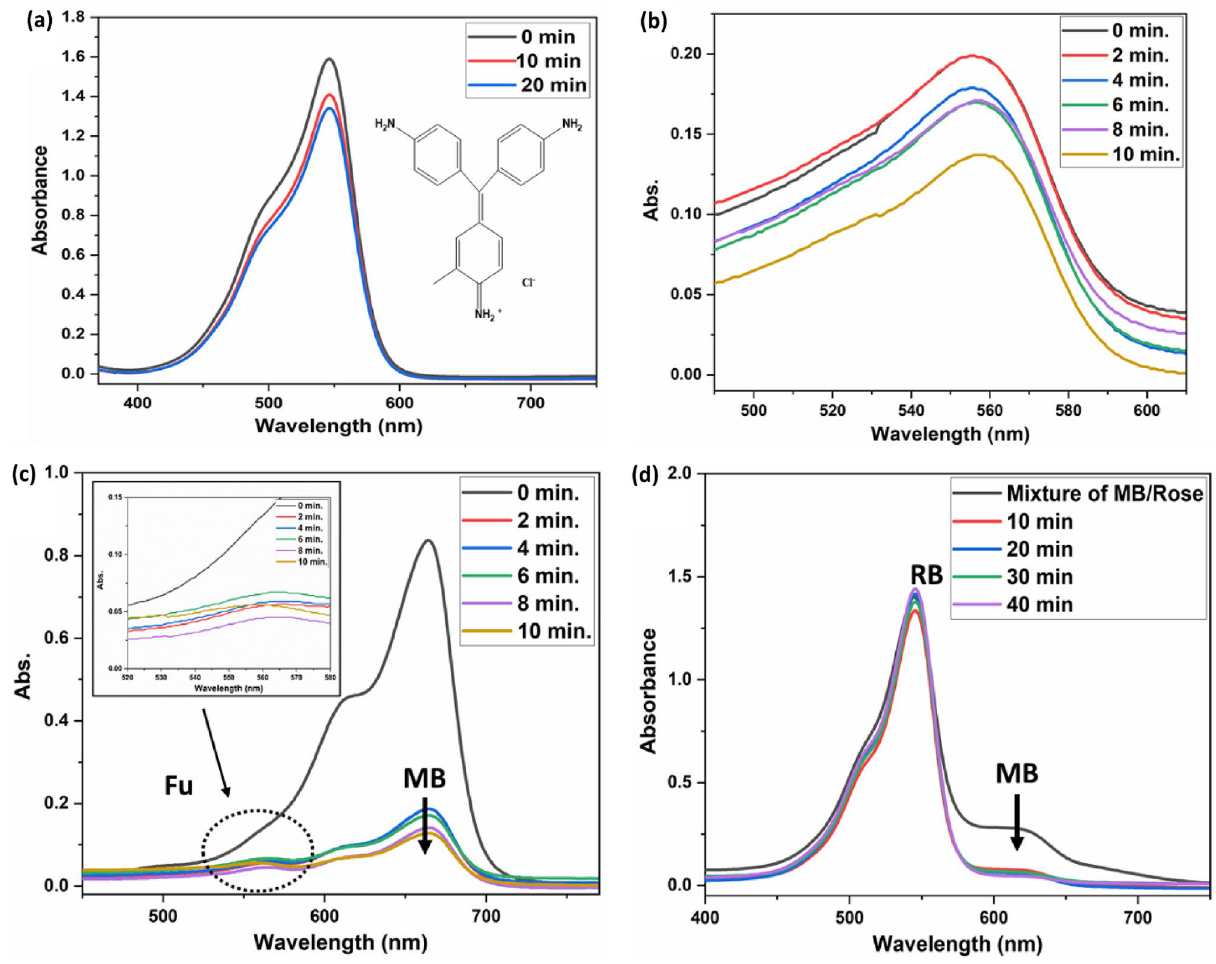
Figure 11. ( a ) Show UV–Vis spectra of 40 ppm Fu 0.05 mg PAK with pH 10 . ( b ) UV–Vis spectra of 20 ppm Fu 0.05 mg PAK with pH 7.2. ( c ) UV–Vis spectra of mix 20 ppm MB/20 ppm Fu 0.05 mg PAK with pH 8. ( d ) UV– Vis spectra of mix 20 ppm MB/20 ppm RB 0.05 mg PAK with pH 8.